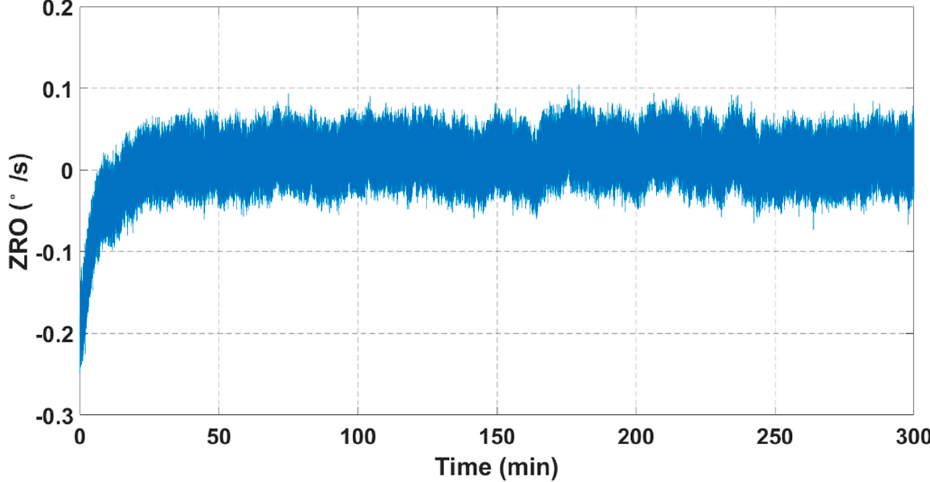
Figure 10. Room − temperature ZRO results.